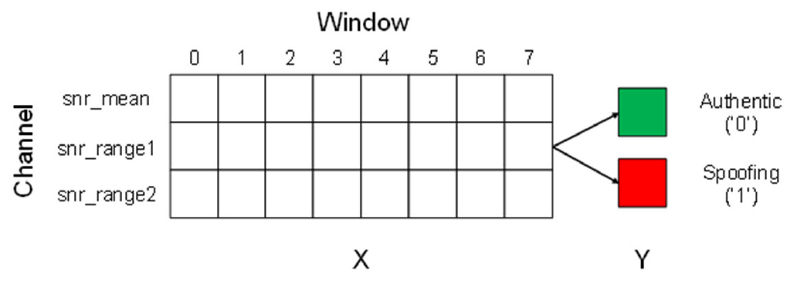
Figure 2. Data preprocessing procedure.